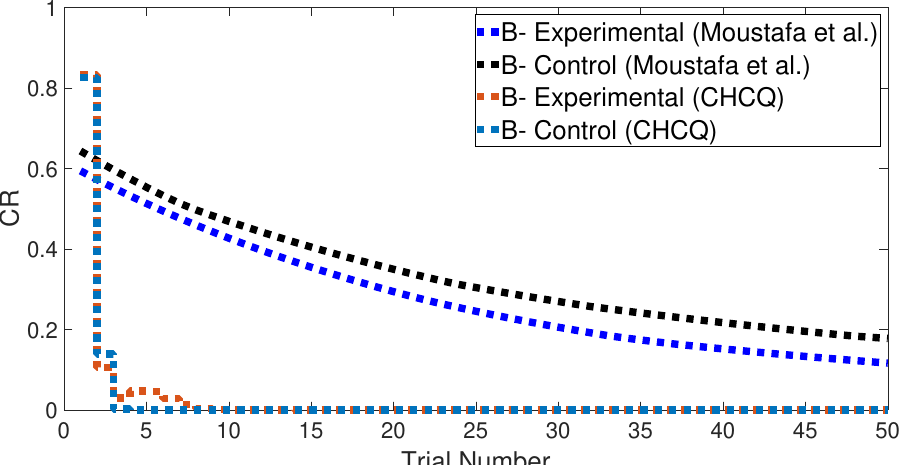
Figure 29. The response of the last phase of sensory preconditioning task for the lesioned